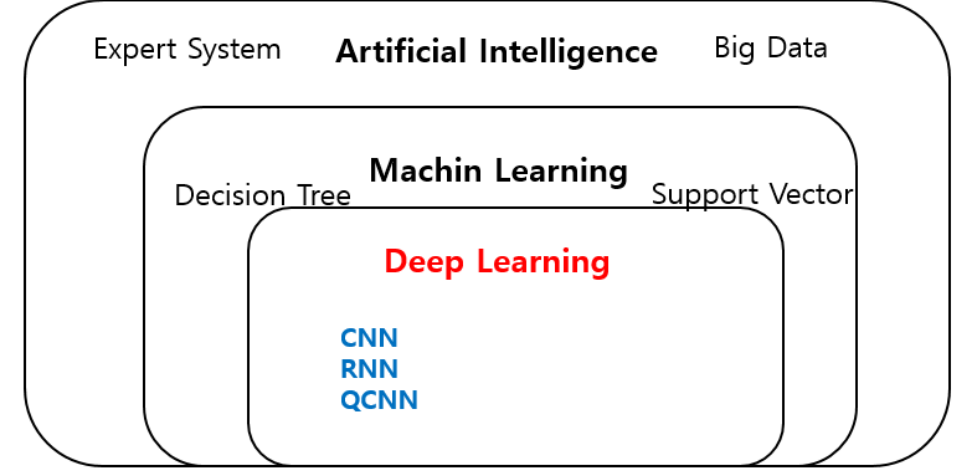
Figure 3. Deep learning architecture.